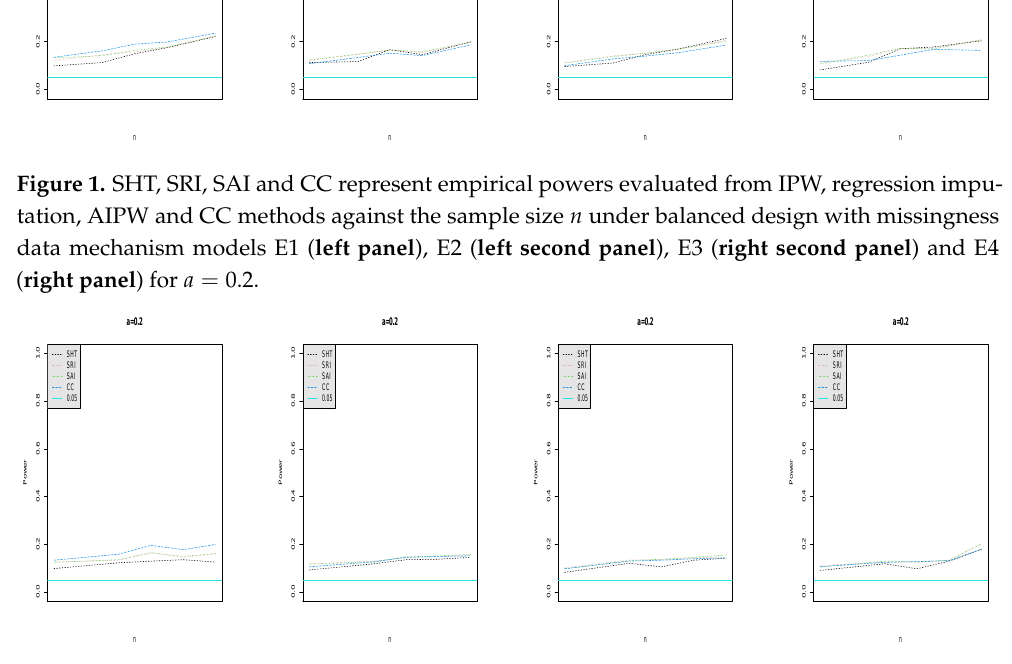
Figure 2. SHT, SRI, SAI and CC represent empirical powers evaluated from IPW, regres- sion imputation, AIPW and CC methods against the sample size n under unbalanced design (i.e., n E : n R : n P = 2:1:1), with missingness data mechanism models E1 ( left panel ), E2 ( left second panel ), E3 ( right second panel ) and E4 ( right panel ) for a =